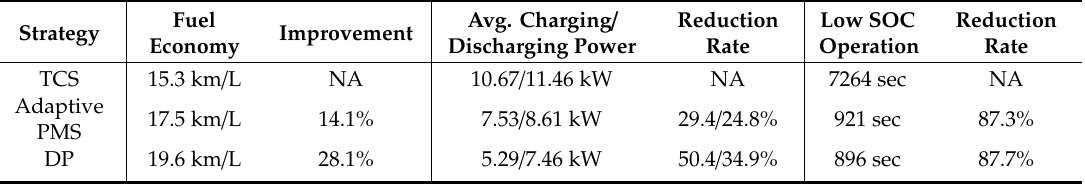
Table 5. Comparison of TCS, adaptive PMS and DP for 6 FTP.